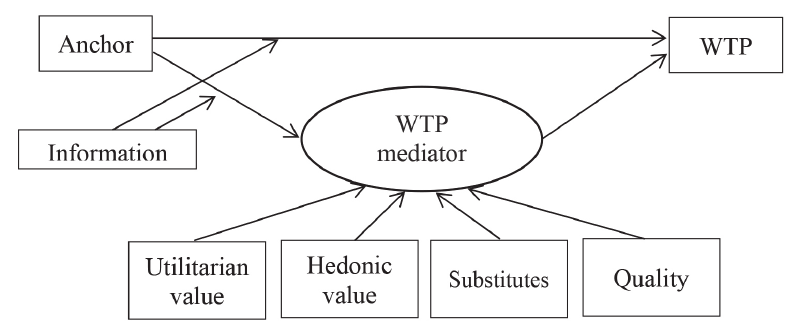
<Figure 1> Effect of Anchor